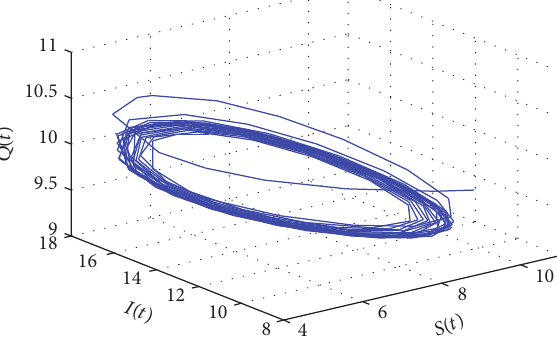
Figure 11: The phase plot of 𝑆 , 𝐼 , and 𝑄 when 𝜏 2 = 1.86251.7852 = 𝜏 20 .